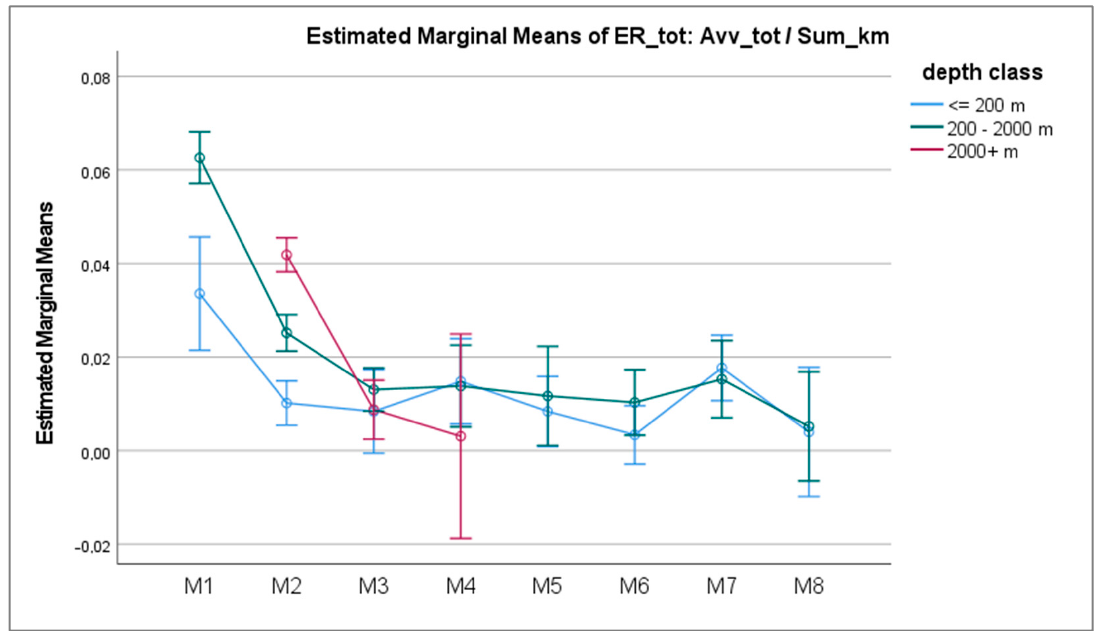
Figure 15. GLM estimated marginal means for geographical subzone and depth class (encounter rate).